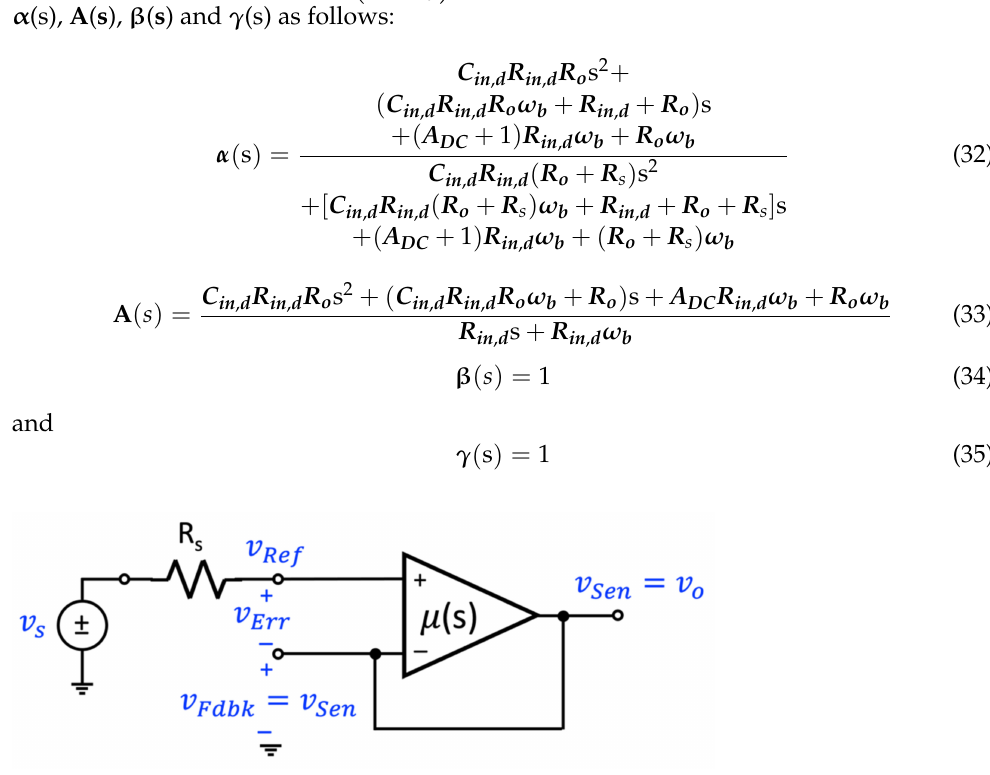
Figure 11. A unity-gain amplifier circuit that is to be mapped to the modified single-loop feedback structure of Figure 10. The circuit is the same, but the voltage-mixing variables have been